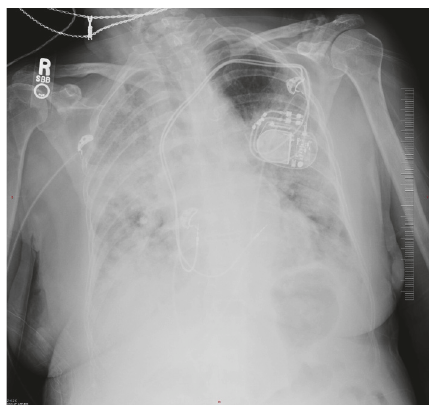
Figure 4: A chest X-ray, taken 5 days after the chest X-ray depicted in Figure 3, revealing rapid progression of lung infiltrates in multiple